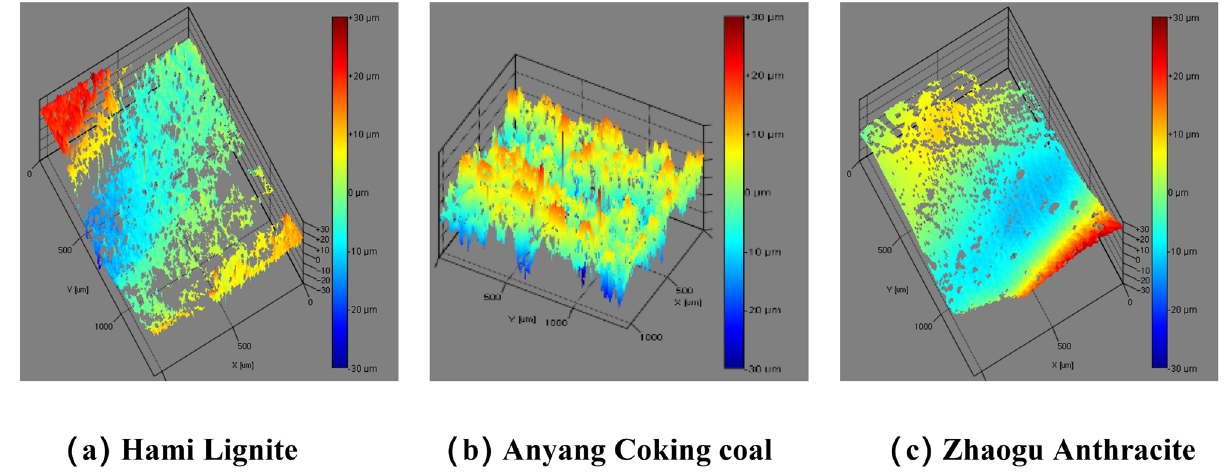
Figure 4. 3D reconstructed topography images of the three coal